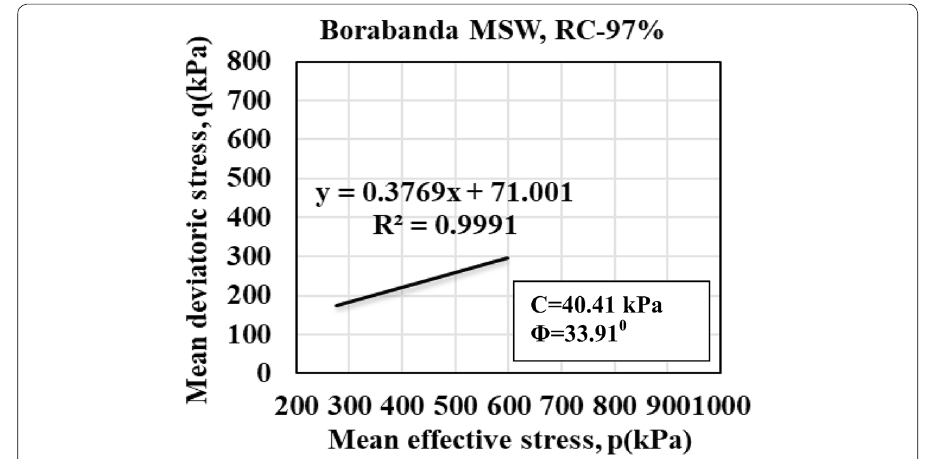
Fig. 32 p–q diagram of Borabanda MSW at RC-97%